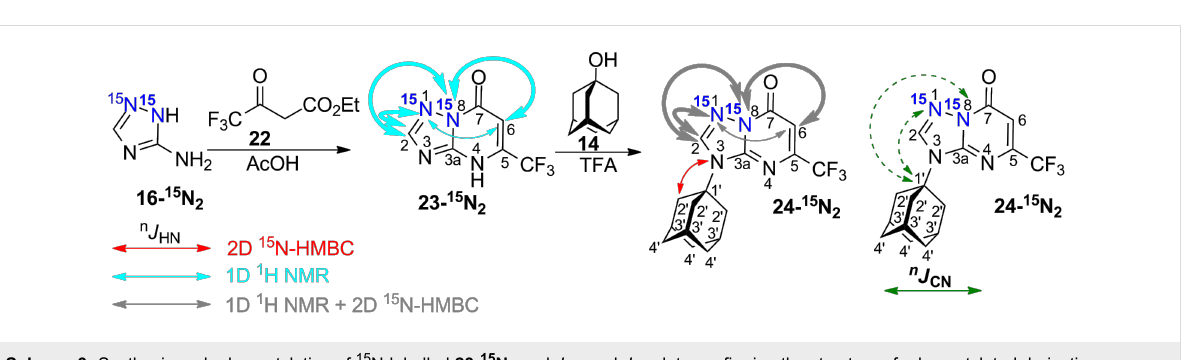
Scheme 3: Synthesis and adamantylation of 15 N-labelled 23- 15 N 2 and J HN and J CN data confirming the structure of adamantylated derivative 24- 15 N 2 . The J HN couplings measured in the 1D 1 H spectra and detected in the 2D 15 N-HMBC spectra are shown by grey, cyan, and red arrows (see the legend in the figure). The measured J HN values (gray and cyan) with magnitudes J ≥ 3 Hz and J < 1 Hz are indicated by the bold and thin solid arrows, respectively. The correlation between H2' and the unlabelled N3 atom observed in the HMBC spectrum of 24- 15 N 2 is shown by a red arrow. The J CN couplings with the H1' adamantane carbon measured in the 1D 13 С spectrum of 24- 15 N 2 have magnitudes < 1 Hz and are shown by dashed green arrows. The 1 J NN couplings observed in the 1D 15 N NMR spectra of 23- 15 N 2 (13.6 Hz) and 24- 15 N 2 (13.4 Hz) are not shown.